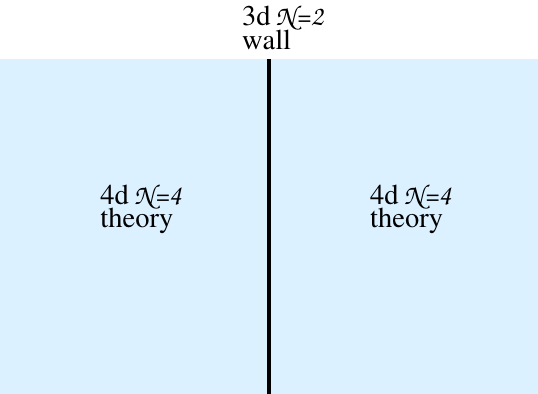
Figure 2 . For genus-1 mapping tori, T [ M 3 ] can be constructed from 1 theory. Note, the 4d N = 4 theory in question is 5d super-Yang-Mills on a circle of (cid:12)nite radius, and 3d walls preserve only 4 out of 16 supercharges, i.e. N = 2 supersymmetry in three